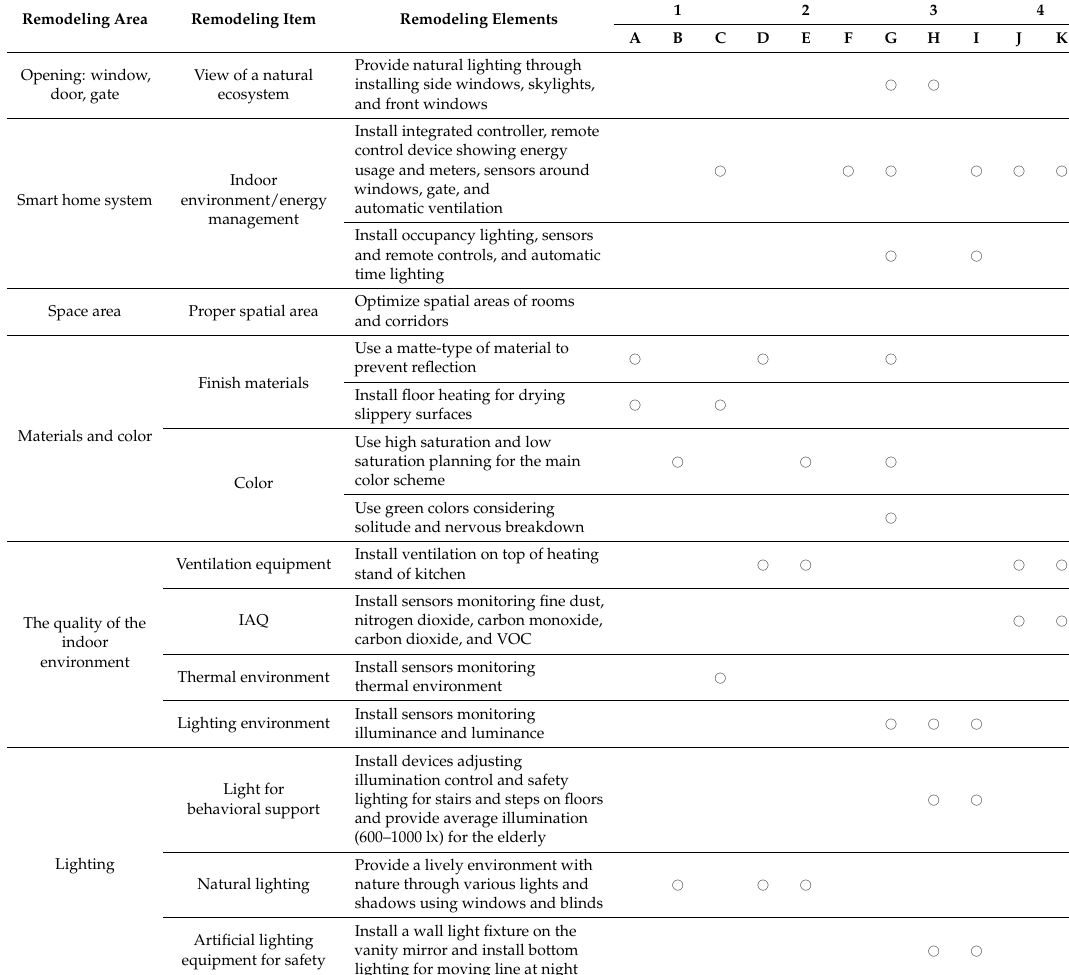
Table 2. Remodeling Elements Related to the Improvement of Energy Performance in Housing for the